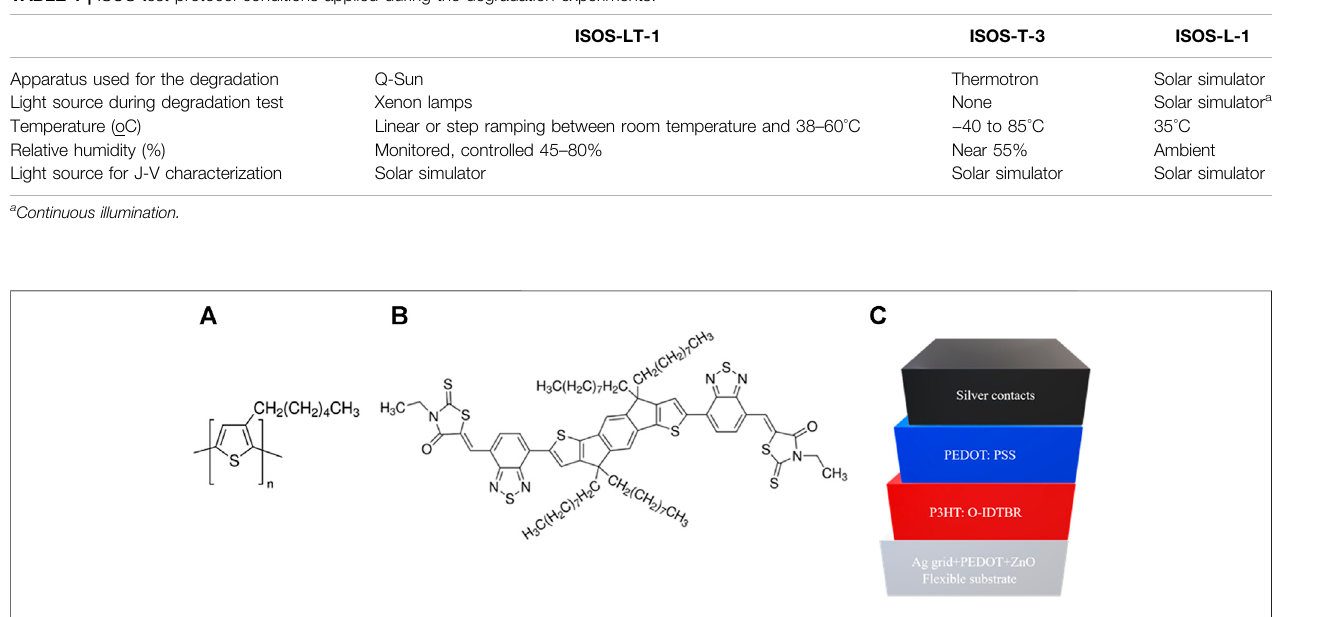
Frontiers in Energy Research |